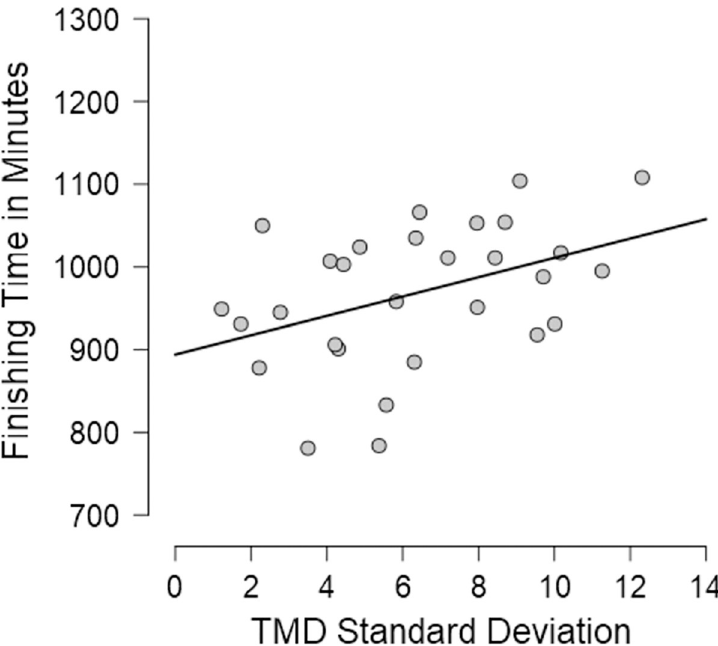
Fig 3. Scatterplot showing the significant, positive correlation between TMD standard deviation scores and finishing time.